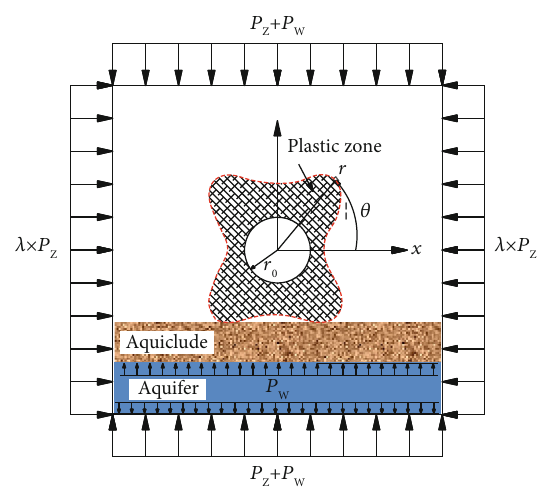
Figure 1: Surrounding rock force model of circular roadway in nonuniform stress fi eld under the in fl uence of water